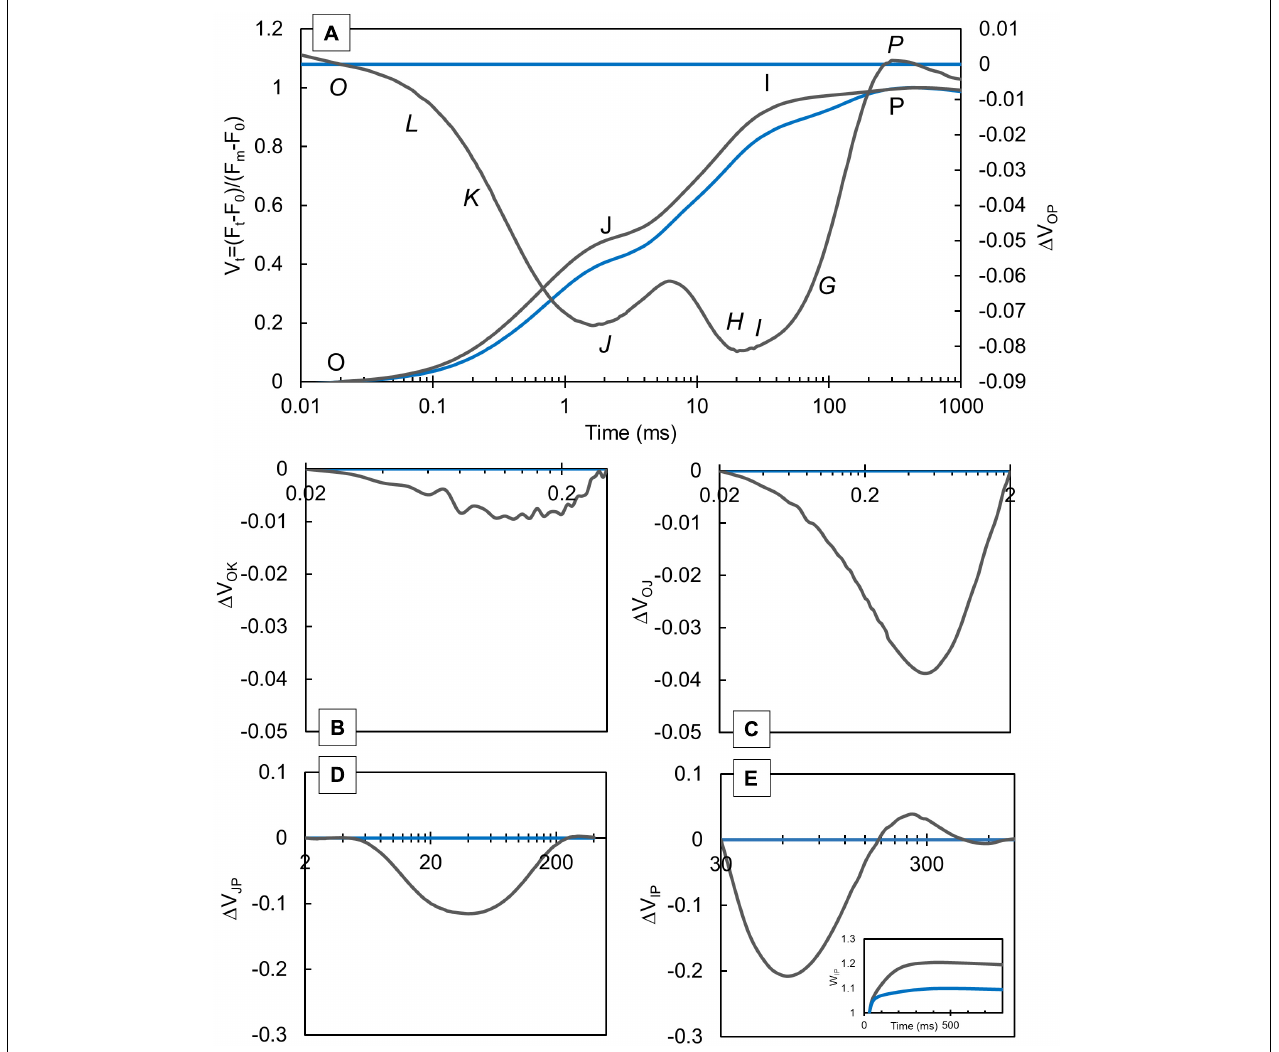
FIGURE 1 | Variations in the shape of the transient curves of the chlorophyll a fluorescence measured in the Japanese knotweed ( Reynoutria japonica Houtt.) leaves exposed to constant low light (blue lines) and fluctuating light (gray lines). Each curve represents the average kinetics of 15 measurements ( n = 15) per treatment. Average fluorescence data were normalized between OP (A) , OK (B) , OJ (C) JP (D) , and IP (E) steps and plotted as difference kinetics (cid:49) Vt in a different time range. Average values measured in constant low light were used as referent values. The relative variable fluorescence transient, V t (A) , shows typical O-J-I-P steps, while in difference kinetics, (cid:49) V OP , specific bands O-L-K-J-I-H-G-P can be